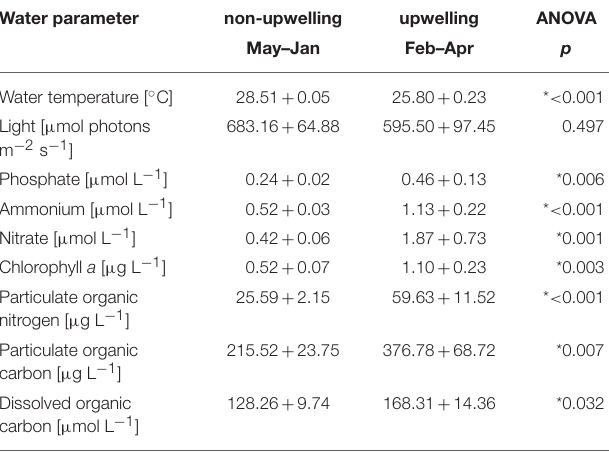
TABLE 1 | Environmental parameters under non-upwelling and upwelling conditions.